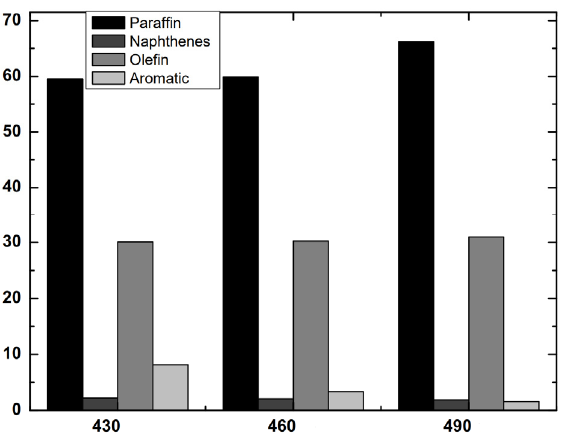
Figure 4. Composition of pyrolysis oils of PT-Film pyrolyzed at different temperatures.